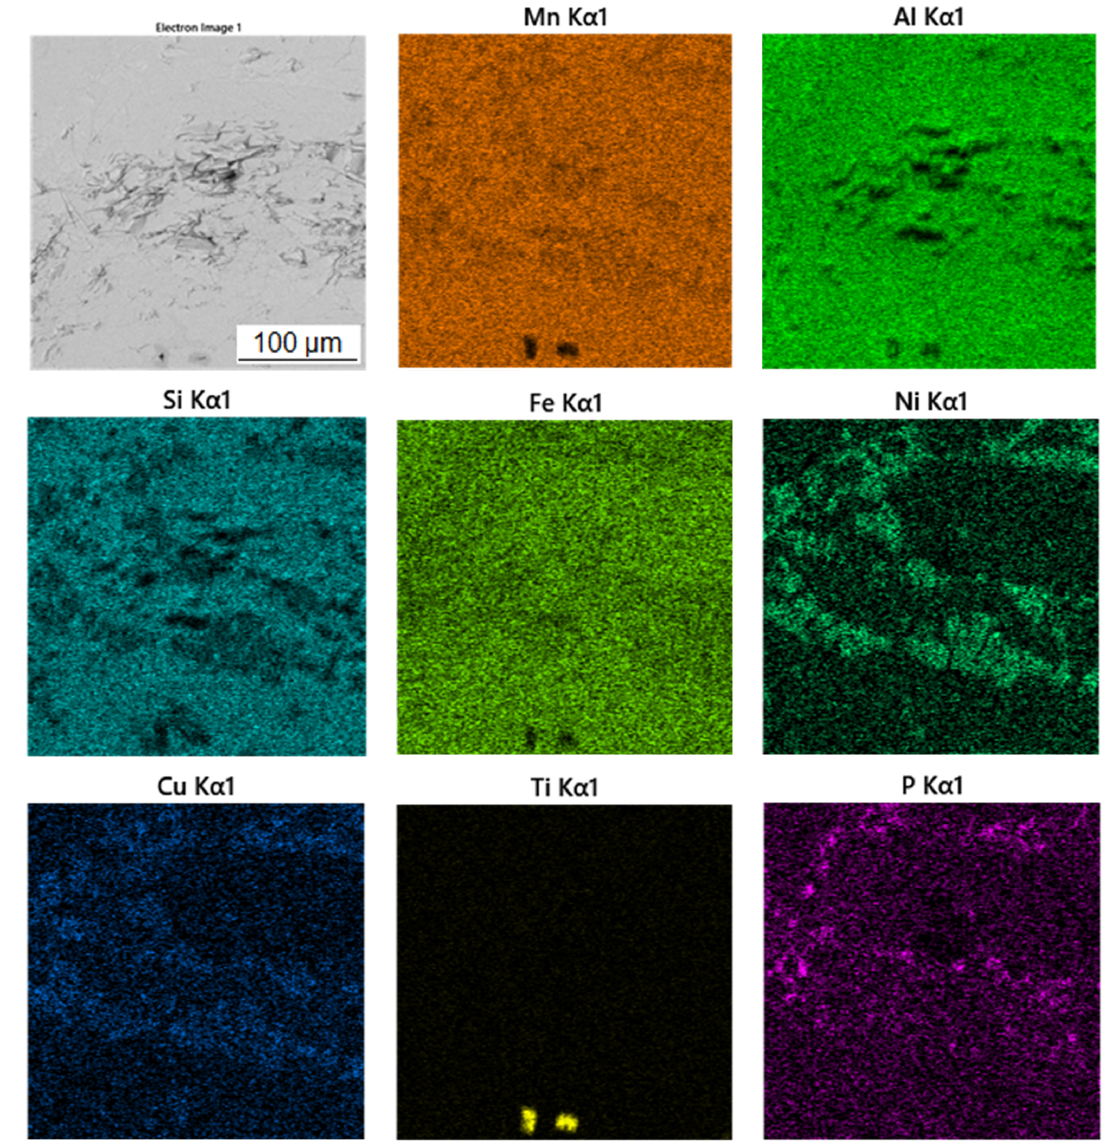
Figure 4. EDS map of the distribution of the elements of the sample in the reduced state.